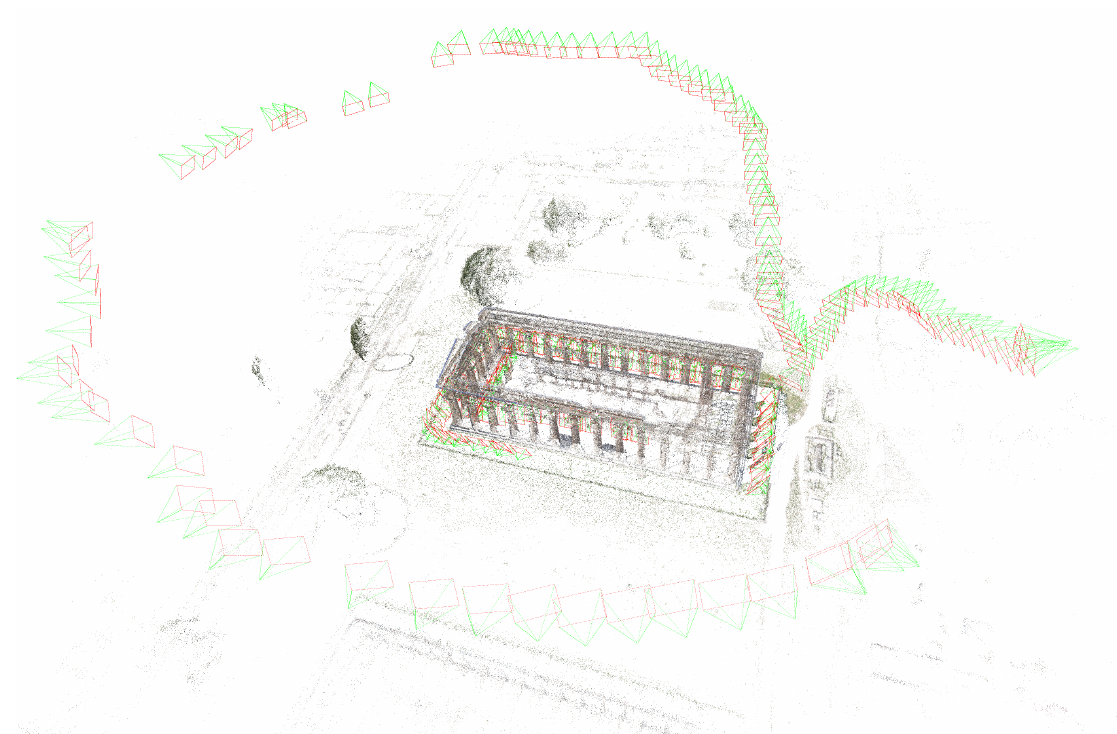
Figure 9. Nettuno dataset : successful interoperable OpenMVG+MicMac process on low overlapping UAV and terrestrial.